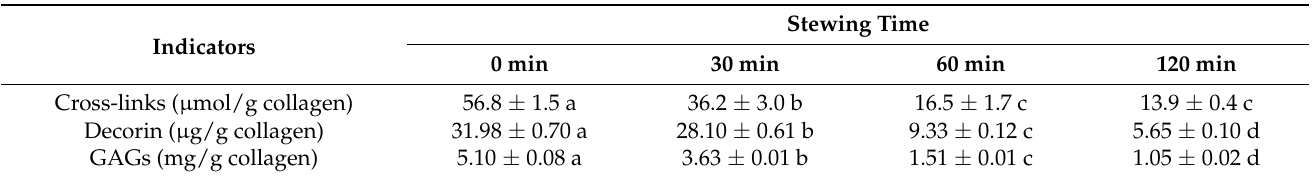
Table 2. The effect of stewing time (0, 30, 60 and 120 min) on the cross-links, decorin and glycosamino- glycan (GAGs) of